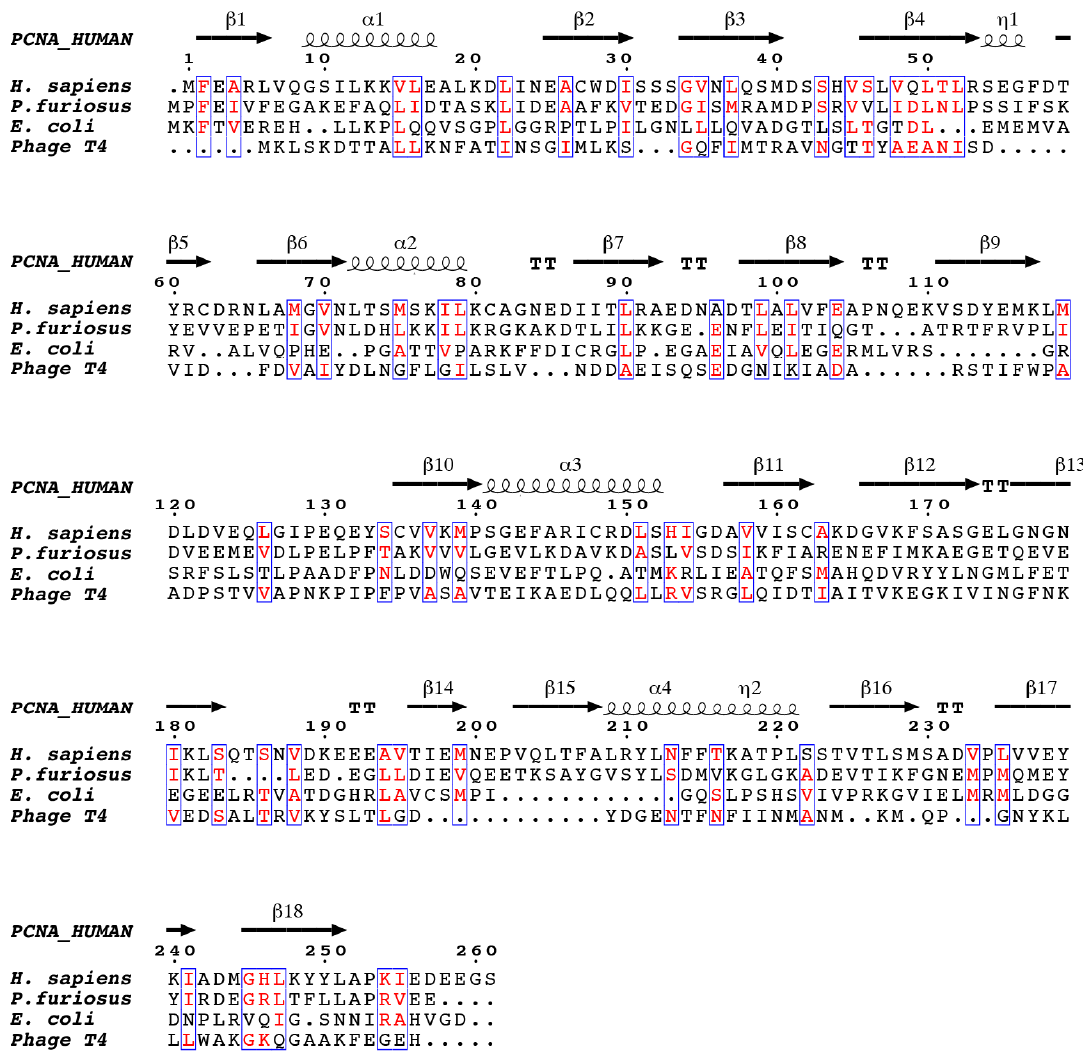
Figure 1. The structure-based sequence alignment of DNA sliding clamps from H. sapiens , P. furiosus, E. coli , and the gp45 gene of bacteriophage T4. The alignment was performed with chain A from each of the PDB files, which corresponds to one of the three protomers (in the case of E. coli , which consists of two protomers, only the N-terminal two thirds of the sequence are shown). Similar residues are colored red. Secondary structure elements corresponding to human proliferating cell nuclear antigen (PCNA) are shown above the alignment, β -strands are indicated as arrows, α -helices as spirals, and β -turns as TT. The figure was generated with ESPript.